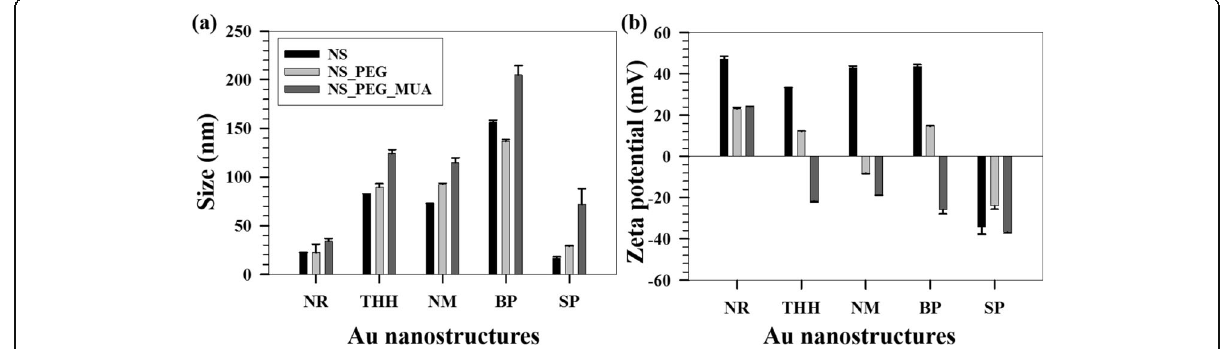
Fig. 4 Sizes and zeta potentials of Au NSs. a Variation of DLS sizes of the Au NSs after each stage of functionalization. b Variation of zeta potentials of Au NSs with each stage of functionalization. X -axis represents Au nanostructure of different shapes (NR nanorods, THH tetrahexahedra, NM nano makura , BP bipyramid, SP